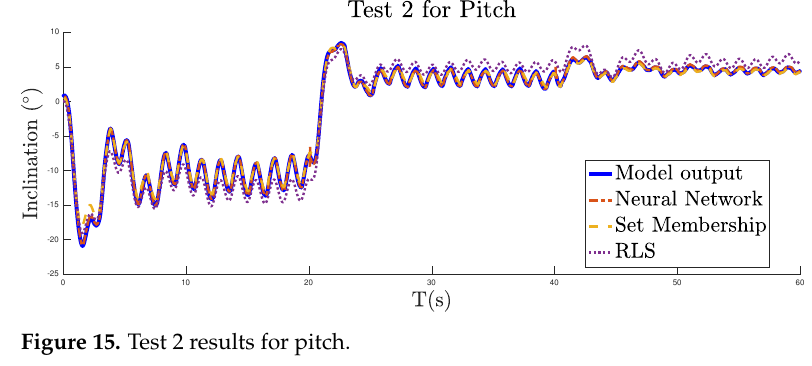
Figure 15. Test 2 results for pitch.